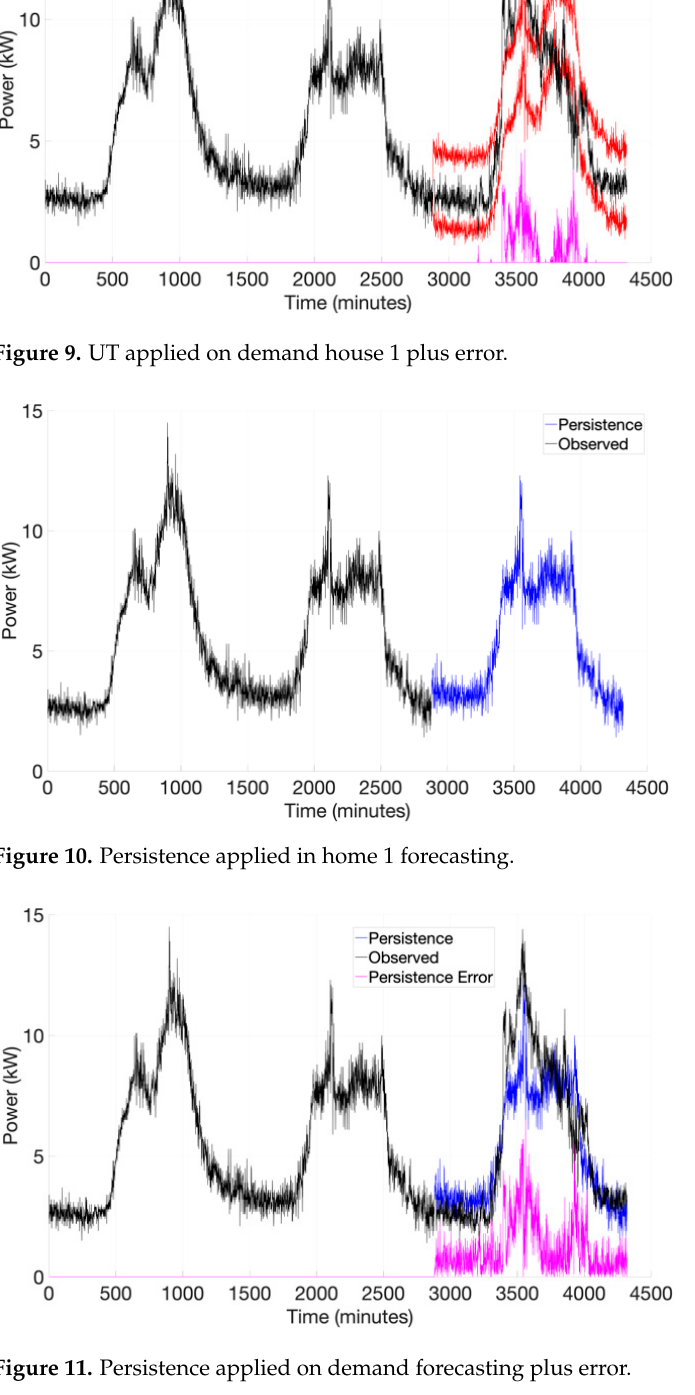
Figure 11. Persistence applied on demand forecasting plus error.